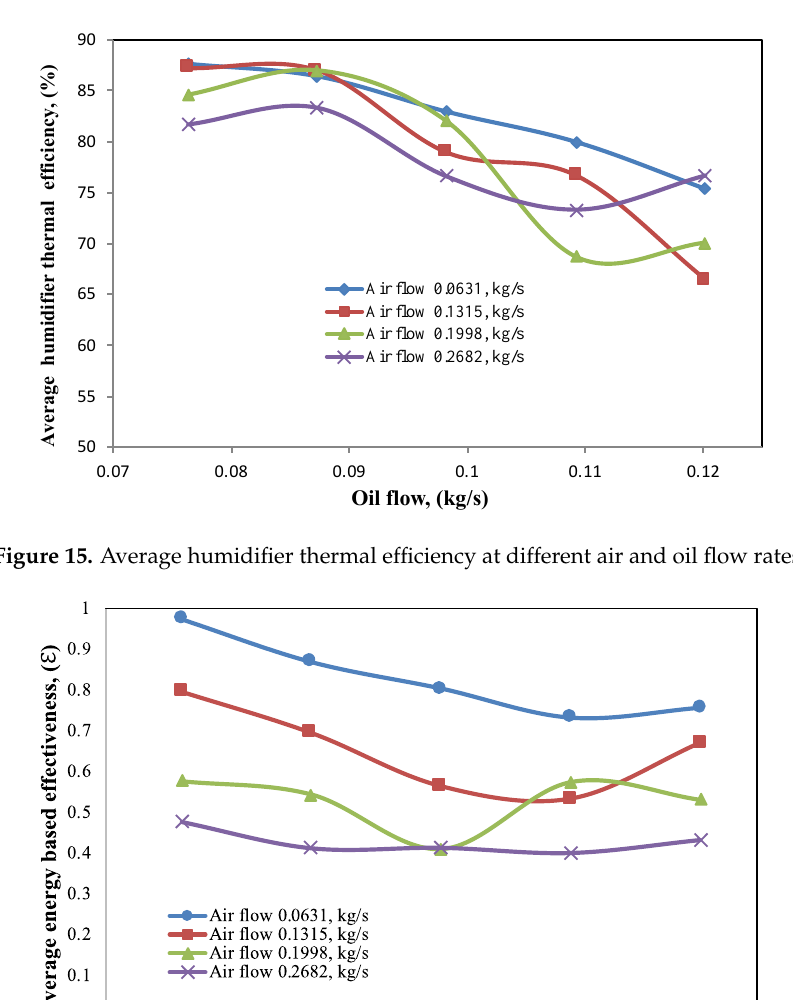
Figure 14. Average humidifier efficiency at different air and oil flow rates.